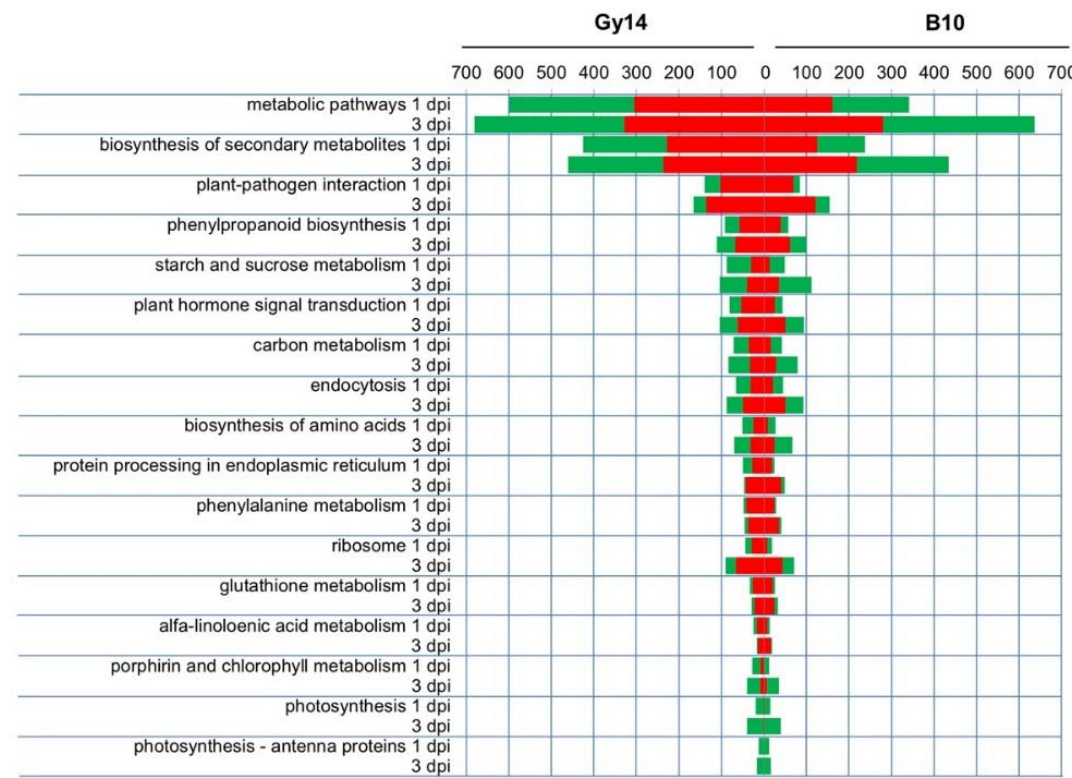
Figure 6. Summary of the Kyoto Encyclopedia of Genes and Genomes (KEGG) pathway enrichment analysis in Gy14 and B10 lines at 1 and 3 dpi. Red and green indicate up- and down-regulated differentially expressed genes (DEGs), respectively.